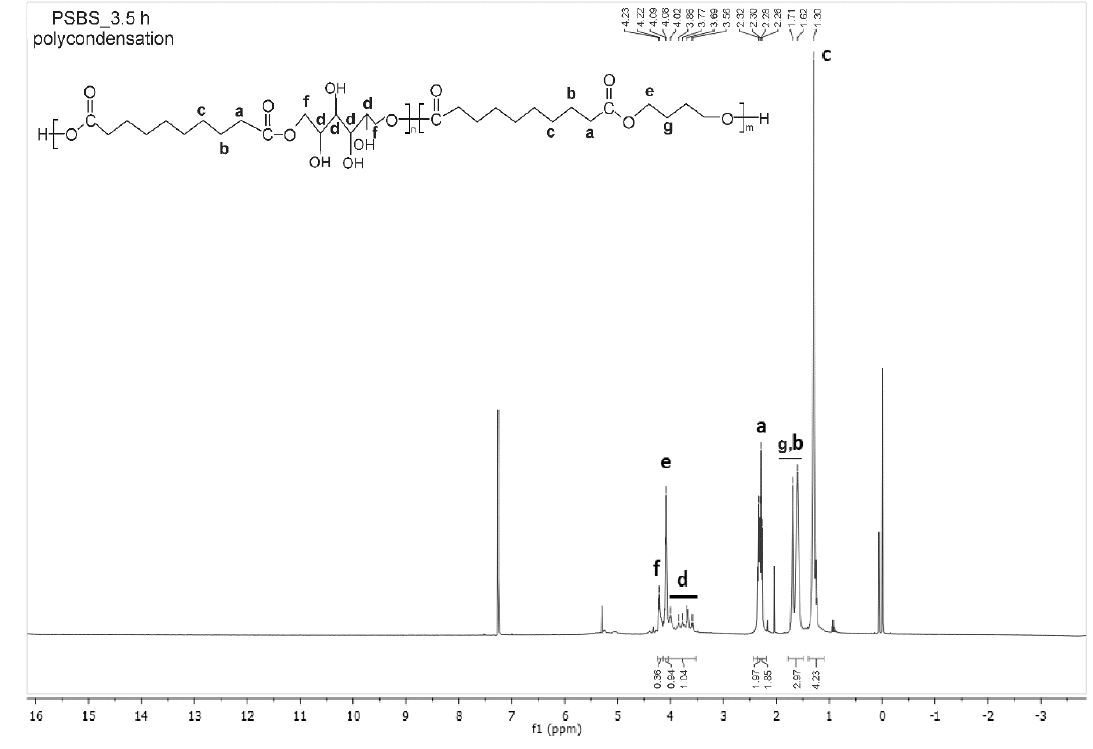
Figure 7. NMR analysis of PSBS 3.5 h.